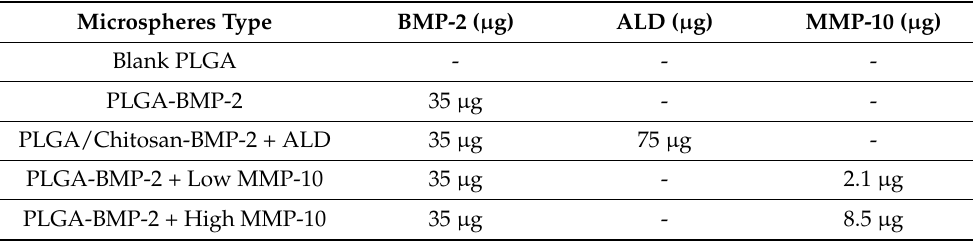
Table 1. Developed PLGA microspheres and drug amounts used per